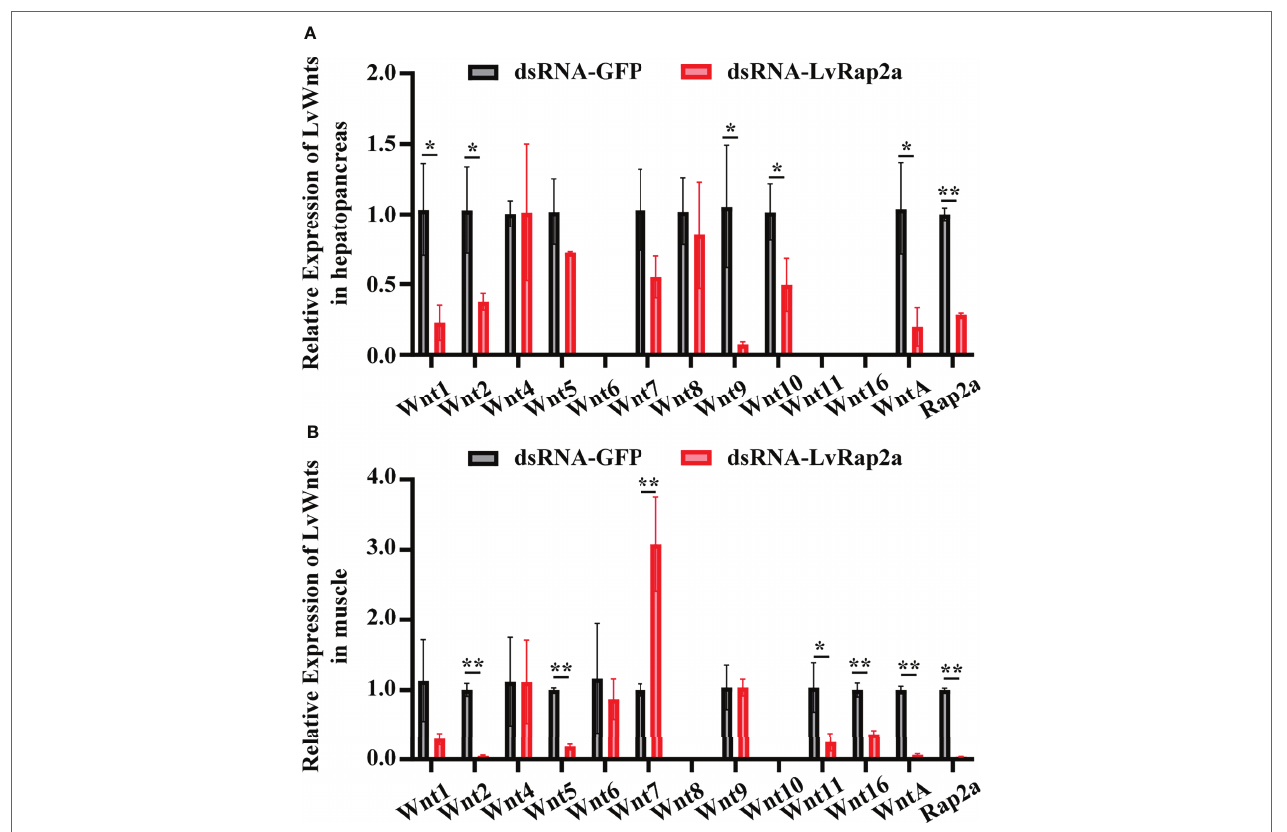
FIGURE 5 | Wnts were regulated by LvRap2a. Relative expression levels of all the twelve Wnts in hepatopancreases (A) and muscle (B) of L. vannamei were detected via qRT-PCR at 48 hours (2-day) post dsRNA injection. The transcription level of each gene in dsRNA-GFP group was normalized to 1.0. Asterisks indicate significant differences (* p < 0.05 and ** p < 0.01). All the experiments were performed two times with identical